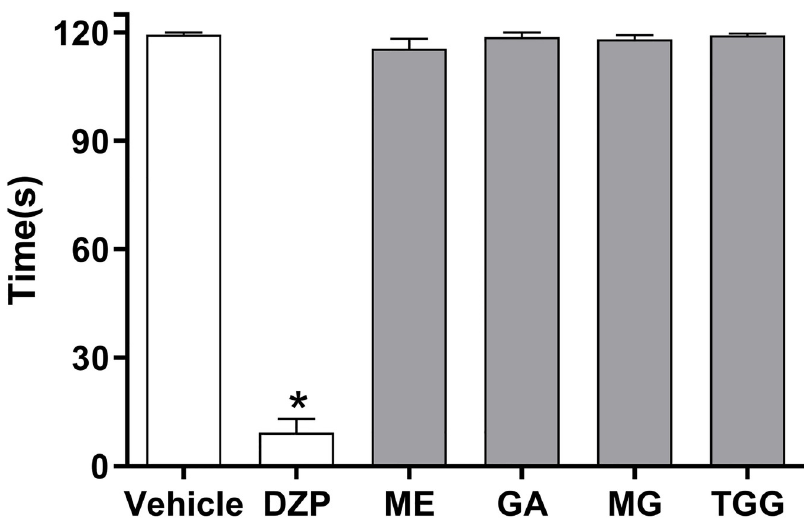
Fig 5. Effects of ME, gallic acid, methyl gallate and 1,2,6-tri-O-galloyl- β - D -glucopyranose from D . vandellianum on motor function in mice. Bar graph representing the run time on the rotarod, 40 min after intraplantar injection of ME (200 mg/kg), gallic acid (GA; 200 mg/kg), methyl gallate (MG; 200 mg/kg), 1,2,6-tri-O-galloyl- β - D -glucopyranose (TGG; 200 mg/kg), diazepam (DZP; 10 mg/kg, reference drug) or vehicle (saline; control group). Data are reported as means ± SEM; n = 6 mice per group. � Significantly different from the vehicle group ( p < 0.001). One-way ANOVA followed by the Tukey’s test.